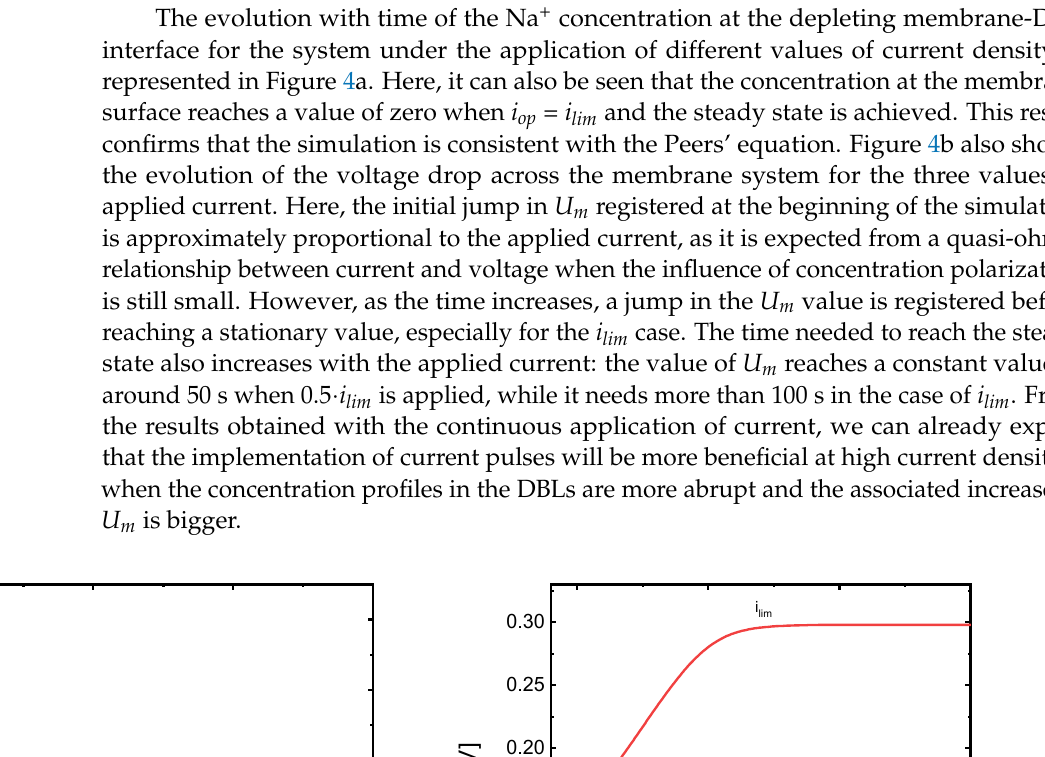
Figure 3. Na + concentration profile along the diffusion boundary layers for the membrane system under: ( a ) application of i lim at different times; ( b ) application of different current densities once the steady state is achieved.